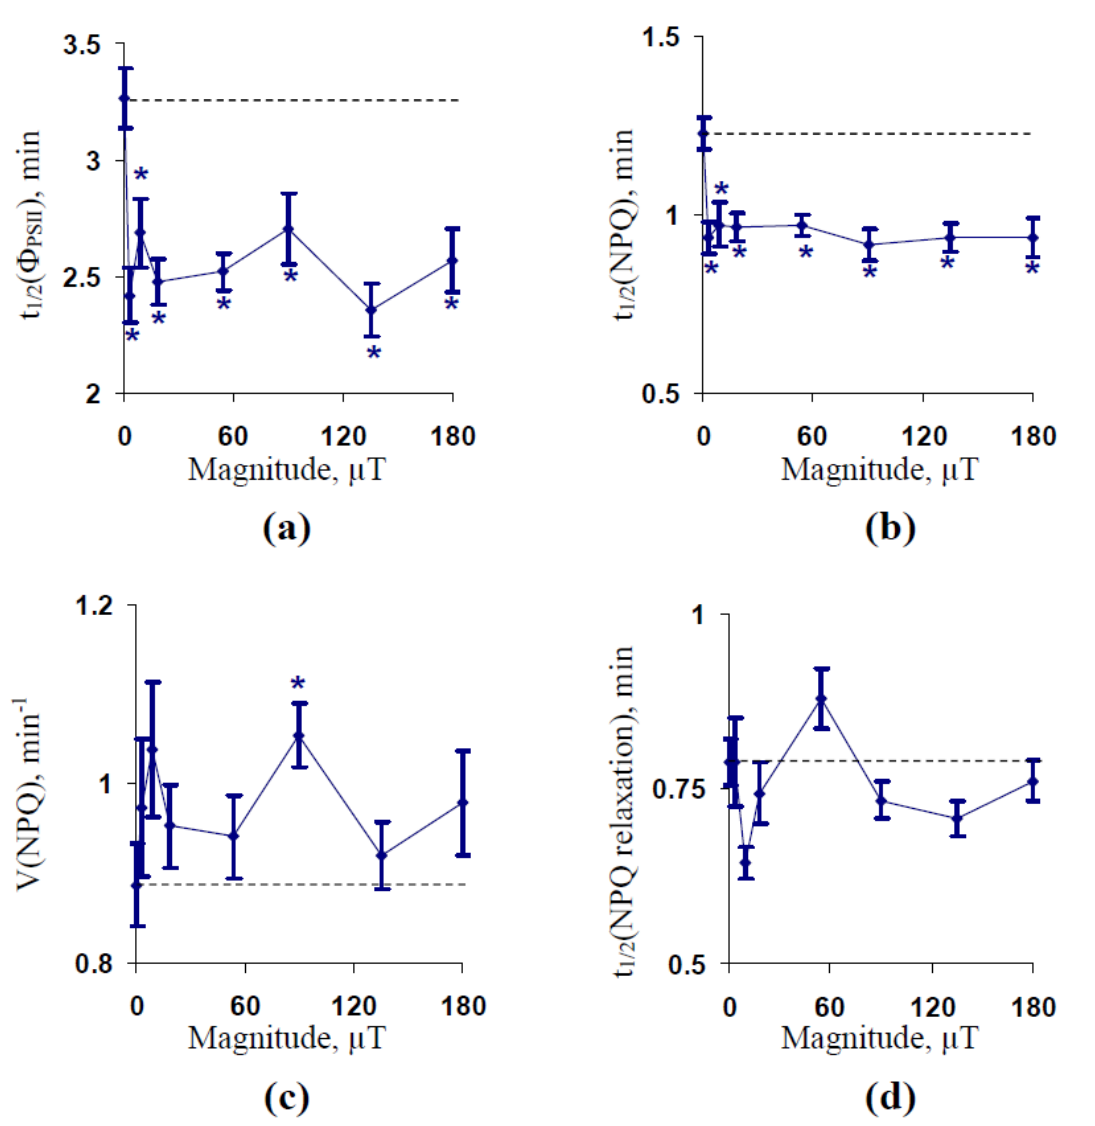
Figure 3. Dependencies of time taken for 50% increase in Φ PSII under illumination (t 1/2 ( Φ PSII )) ( a ), time taken for 50% increase in NPQ under illumination (t 1/2 (NPQ)) ( b ), the initial velocity of NPQ increasing (V(NPQ)) ( c ), and time taken for 50% relaxation of NPQ after the termination of illumination (t 1/2 (NPQ relaxation)) ( d ) on the magnitude of ELFMF with the 14.3 Hz frequency in wheat seedlings ( n = 20–30). The action of the artificial ELFMF was initiated before the dark adaptation; the 30 min treatment was used. Photosynthetic parameters were measured under the treatment. Control seedlings were not treated by the ELFMF (dotted line marked the photosynthetic parameters in these seedlings). *, the difference between photosynthetic parameters in the experimental and control wheat seedlings was significant ( p <